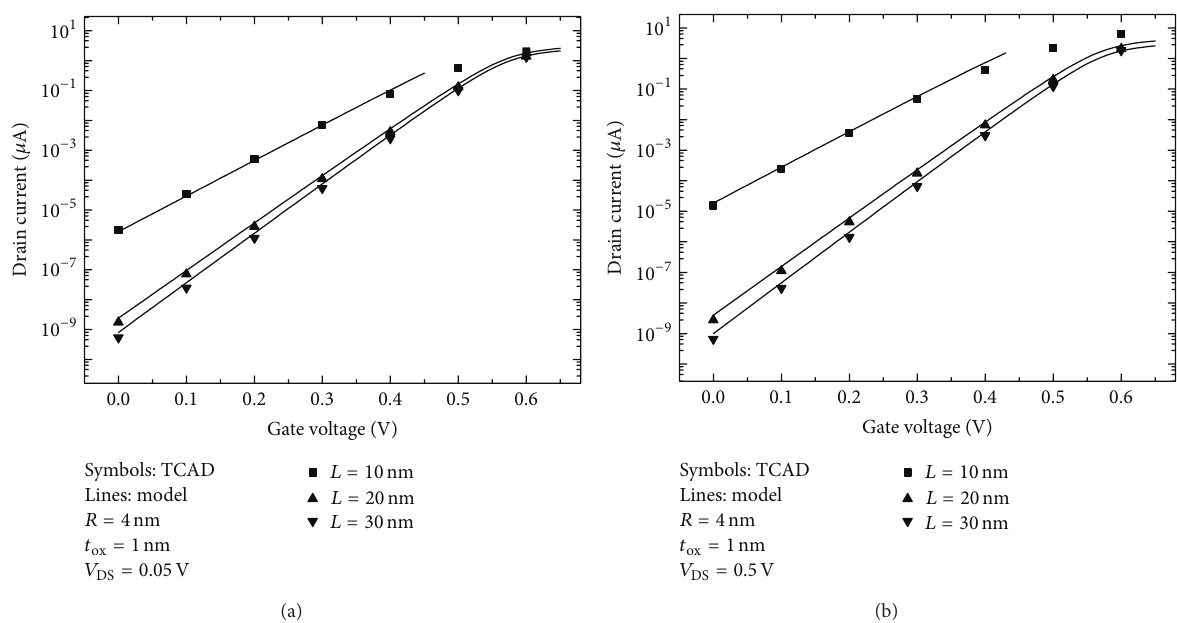
Figure 5: Subthreshold transfer characteristics obtained from the model and TCAD simulation for different gate lengths. The other device parameters are obtained from Table 1. Drain bias is (a) 0.05 V; (b) 0.5 V.